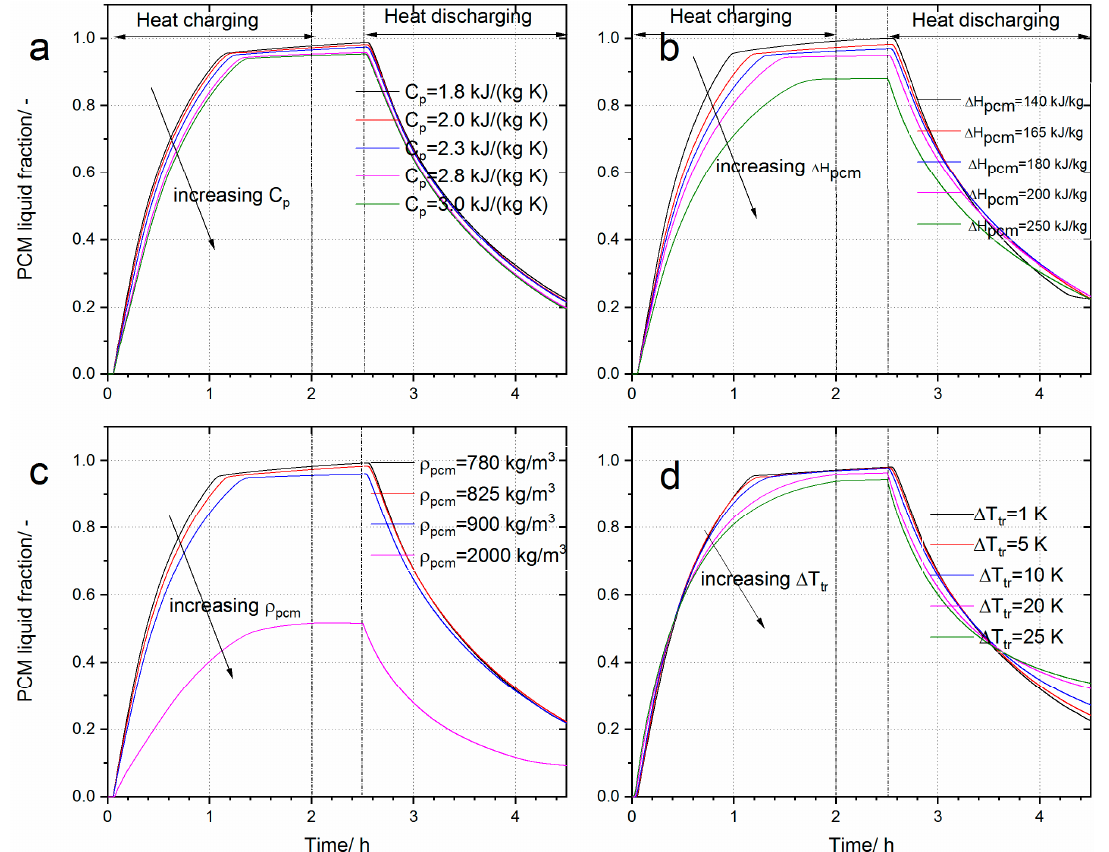
Figure 12. The influence of PCM thermophysical properties on the PCM melting fraction: ( a ) Heat capacity ( b ) the latent heat of fusion, ( c ) the PCM density, ( d ) the phase transition temperature range.